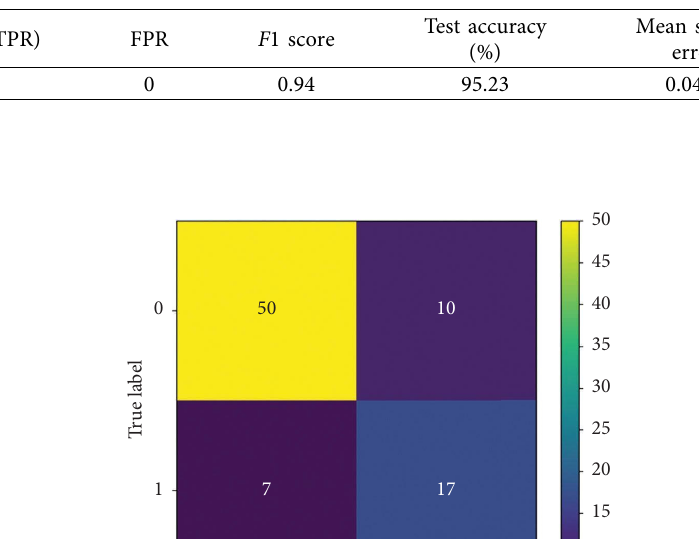
Table 2: ANN classifer parameters.